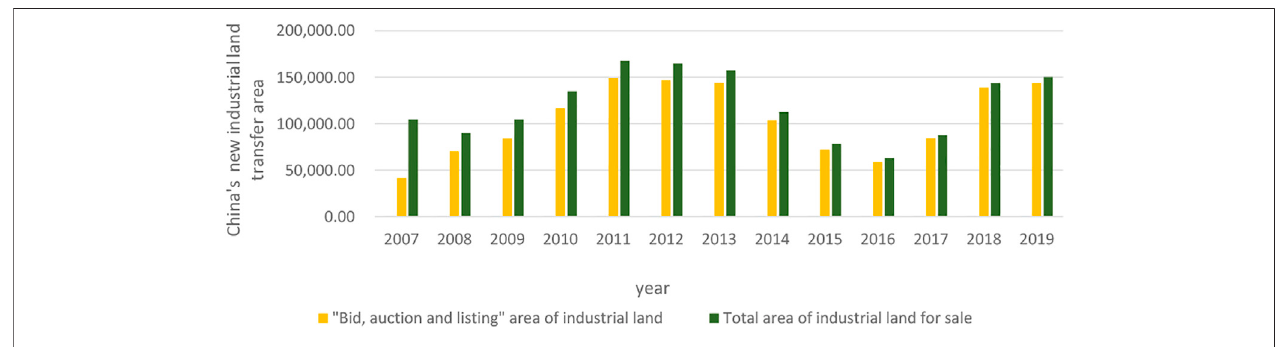
FIGURE 3 | China ’ s industrial land transfer and MIL change. Unit